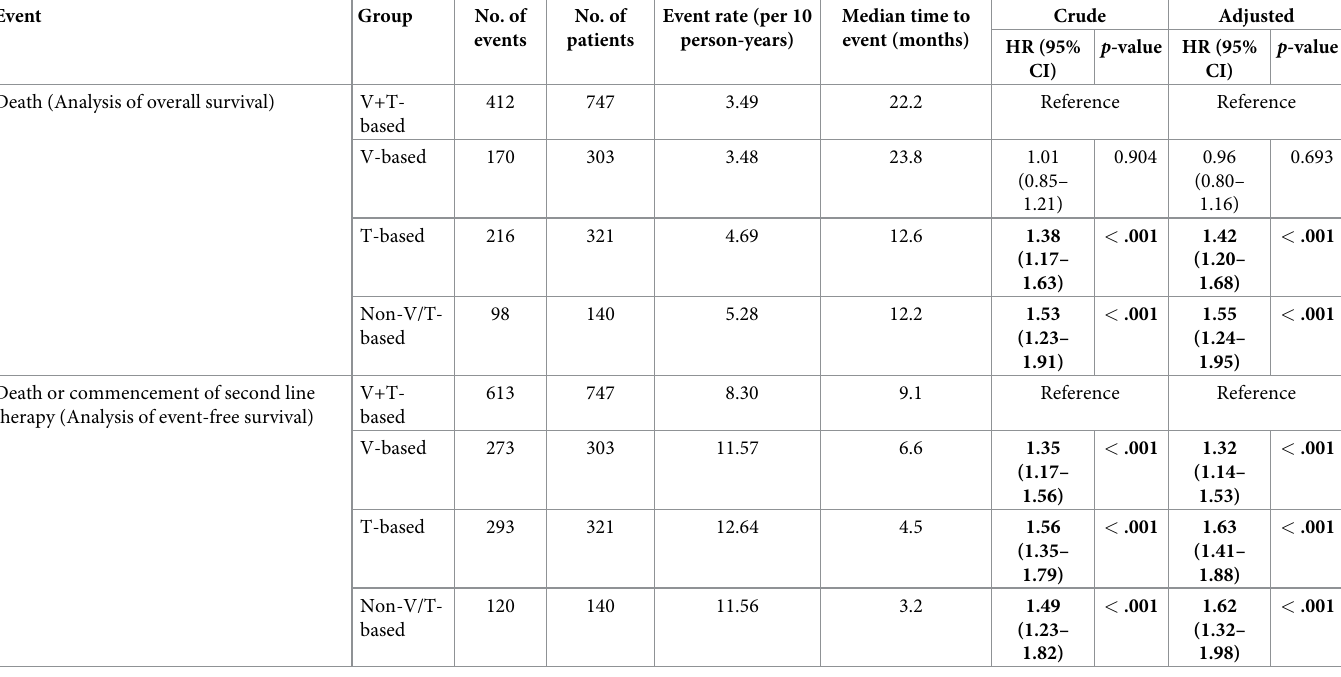
Table 2. Comparison of overall survival and event-free survival among the 1LOT groups.